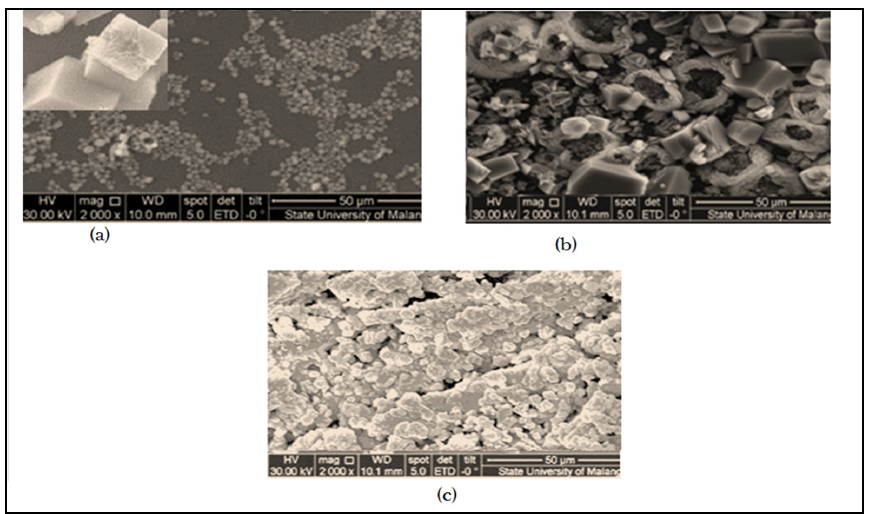
Figure 12. ( a ) ESEM of CaCO 3 scaled membrane without scale inhibitors injection; ( b ) with scale inhibitor DPE injection, and ( c ) with scale inhibitor OAE injection.